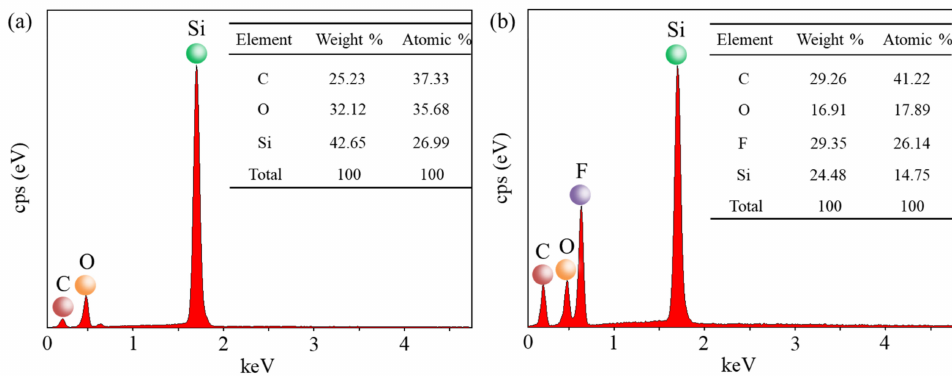
Figure 6. Chemical compositions of the BPF and BSPF. ( a ) EDS spectrum indicates that the main elements of BPF are C, O and Si; ( b ) while the main elements of BSPF are C, O, F and Si.